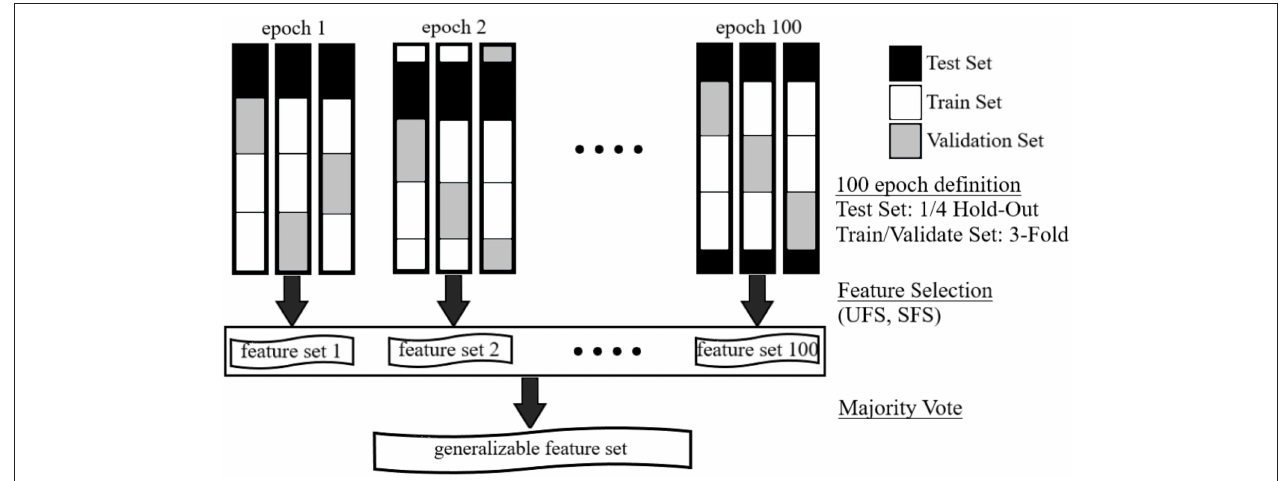
FIGURE 1 | Illustration of one-hundred-epoch hold-out-and- k -fold cross-validation scheme used for machine learning-based feature selection approaches.